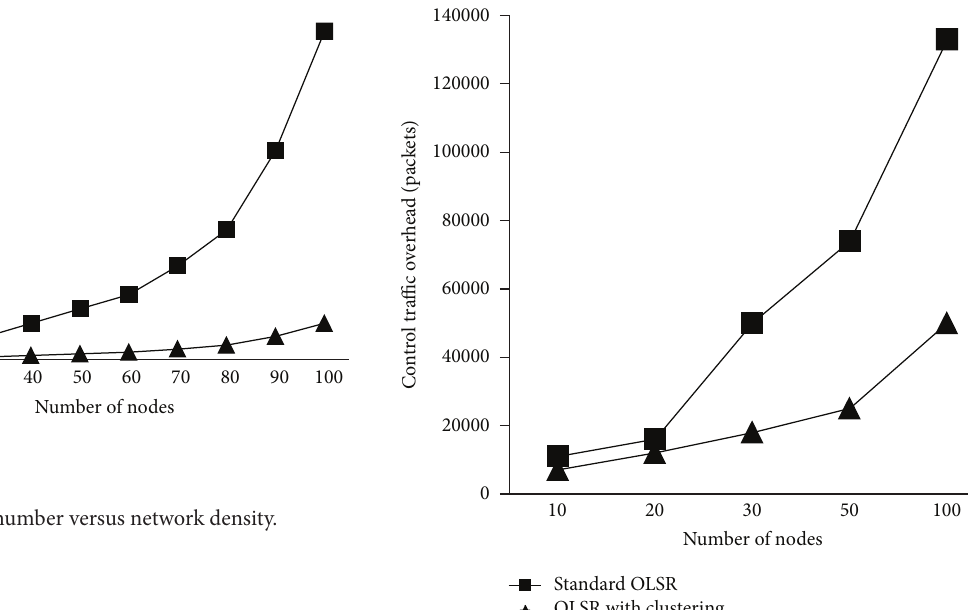
Figure 5: Routing Control Overhead versus Number of nodes.